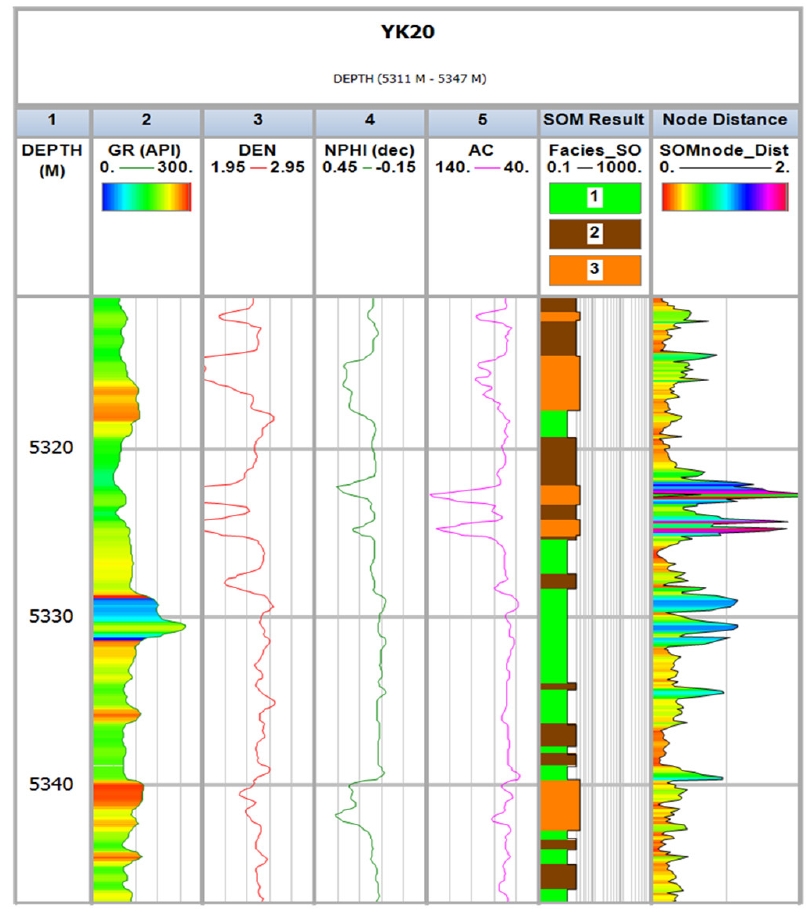
Figure 10. Indicating the distribution of the SOM facies vertically in reservoir intervals.